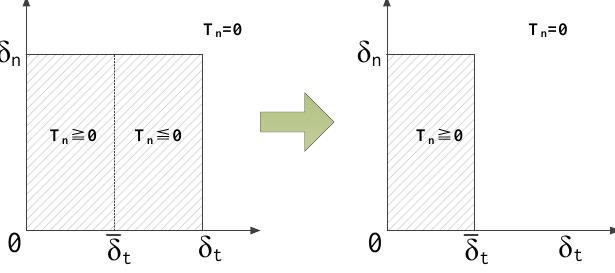
Figure 3. The change of region for the normal traction when 𝜙 𝑛 < 𝜙 𝑡 .